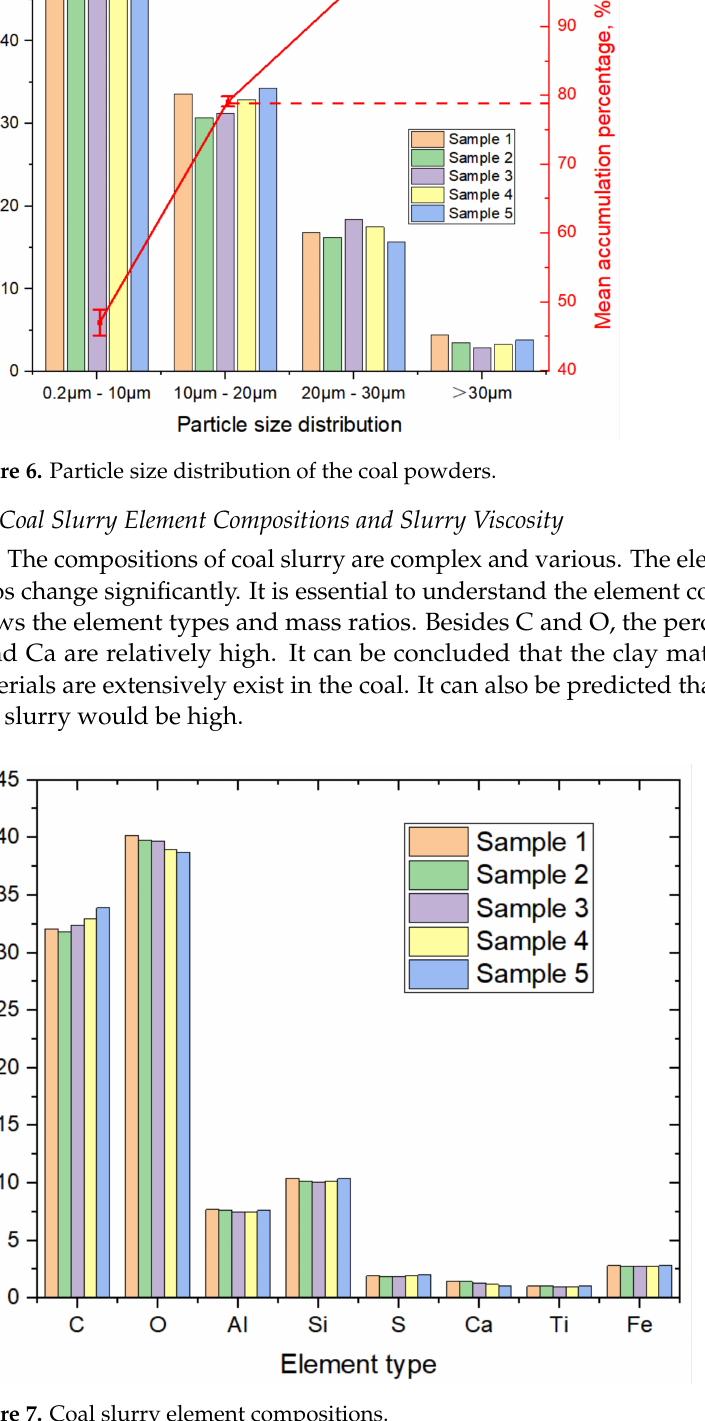
Figure 7. Coal slurry element